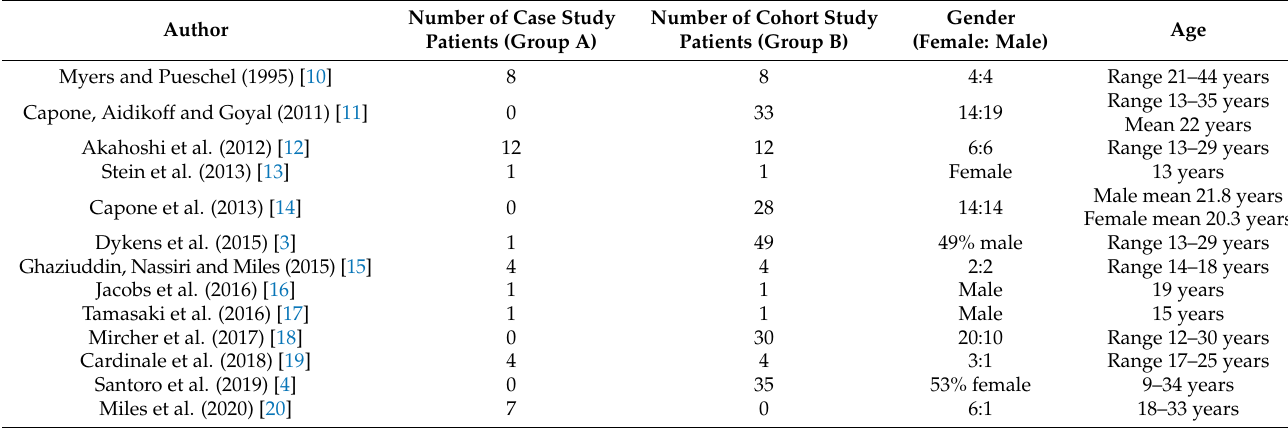
Figure 1. Conceptual framework showing article retrieval and inclusion process. Truncation was used in the search term Down* syndrome so as to capture alternate references such as Down’s and Downs syndrome. Table 1. Summary of articles included in the systematic review.